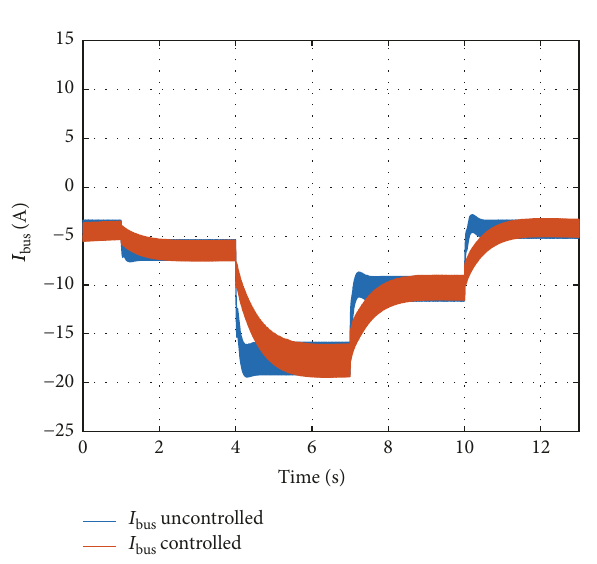
Figure 7: Load variation.